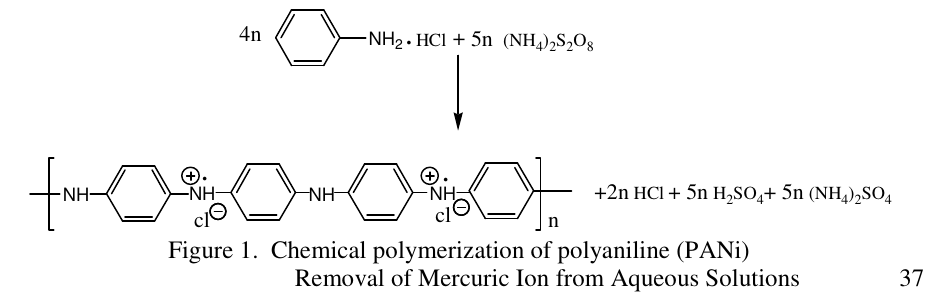
Figure 1. Chemical polymerization of polyaniline (PANi)